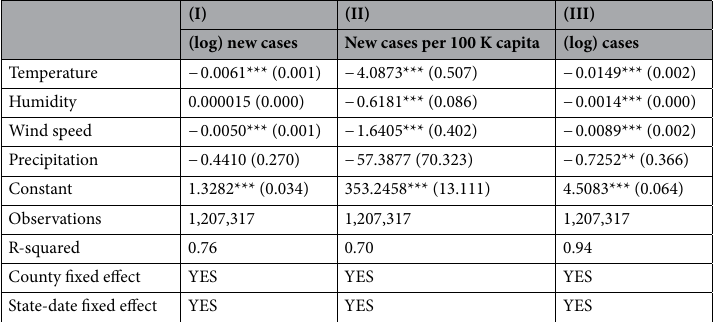
Table 1. The effect of different weather indicators at t-7 (at 12:00 local time) on different pandemic measures. The table reports the coefficients (with standard errors in parentheses) of four weather indicators based on the following regression model (baseline):